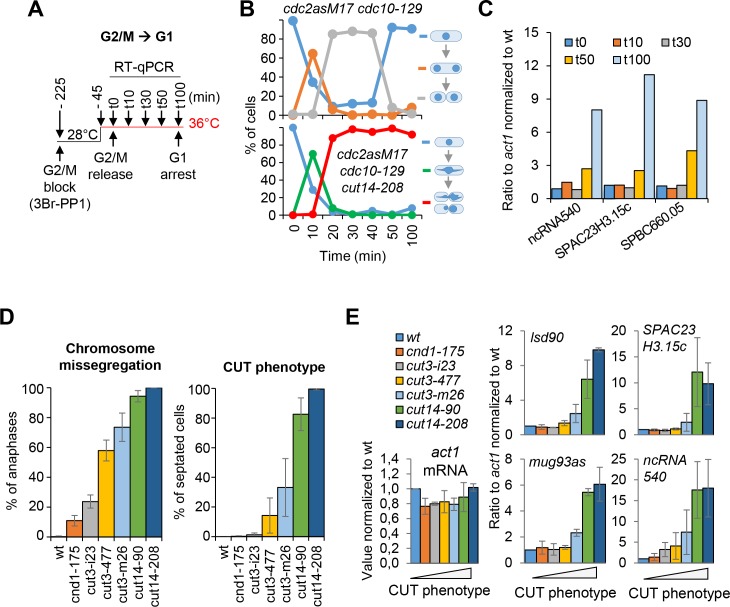
Defective mitosis underlies deregulated gene expression in the fission yeast cut14-208 condensin mutant.(A–C) Gene expression was assessed in synchronized cut14-208 cells progressing through mitosis. (A) Cells expressing the analogue-sensitive Cdc2asM17 kinase were arrested at the G2/M transition in the presence of 3-Br-PP1 (2 µM), shifted at 36°C, released into mitosis and re-arrested in late G1 phase by the cdc10-129 mutation. (B) Mitotic progression was assessed by cytological observation. DNA was stained with DAPI and the septum with calcofluor. The frequencies of chromatin bridges (green line) and chromosome cutting by the septum (red line) are shown. (C) Total RNA extracted from wild-type and cut14-208 cells shown in (B) was reverse-transcribed in the presence or absence of RT and cDNA quantified by qPCR. (D–E) The amplitude of increase in RNA levels correlates with the prevalence of chromosome severing in condensin mutants. Indicated cells were grown at 36°C for 2.5 hr and processed for cytological analysis of chromosome segregation (D) or RT-qPCR (E). (D) Cells were fixed and processed for immunofluorescence against α-tubulin. DNA was stained with DAPI. Chromosome segregation was assessed in anaphase cells exhibiting a mitotic spindle ≥6 µm in length (n ≥ 100). CUT phenotype was assessed by staining DNA with Hoechst 3342 and the septum by calcofluor (n ≥ 100). Shown are averages ± SDs from biological triplicates. (E) Total RNA extracted from cells grown at 36°C was reverse-transcribed in the presence or absence of RT and the cDNA quantified by qPCR. Shown are the averages ± SDs measured from biological triplicates.